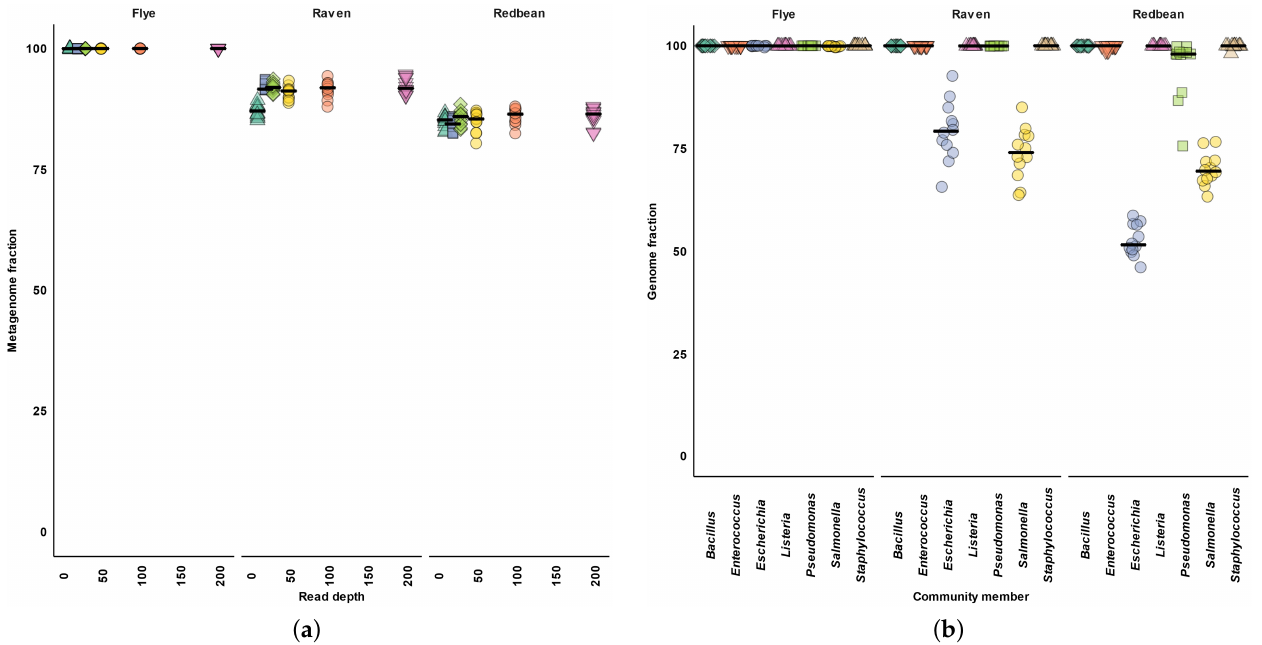
Figure 1. Chromosome completeness. ( a ) Metagenome fraction, percentage of aligned bases to the metacommunity reference genomes in a replicate. ( b ) Genome fraction of each community member with 200 × read depth. Color and shape indicate different community members. Horizontal bars indicate the medians across